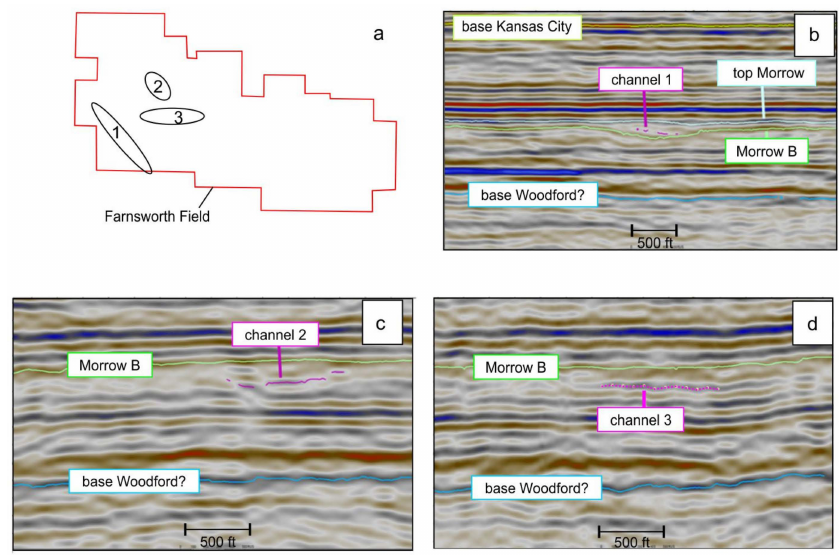
Figure 8. ( a ) Location of three channel-like features in the western Farnsworth Field; ( b ) details of seismic line intersecting channel 1; ( c ) details of seismic line intersecting channel 2; ( d ) details of seismic line intersecting feature 3.